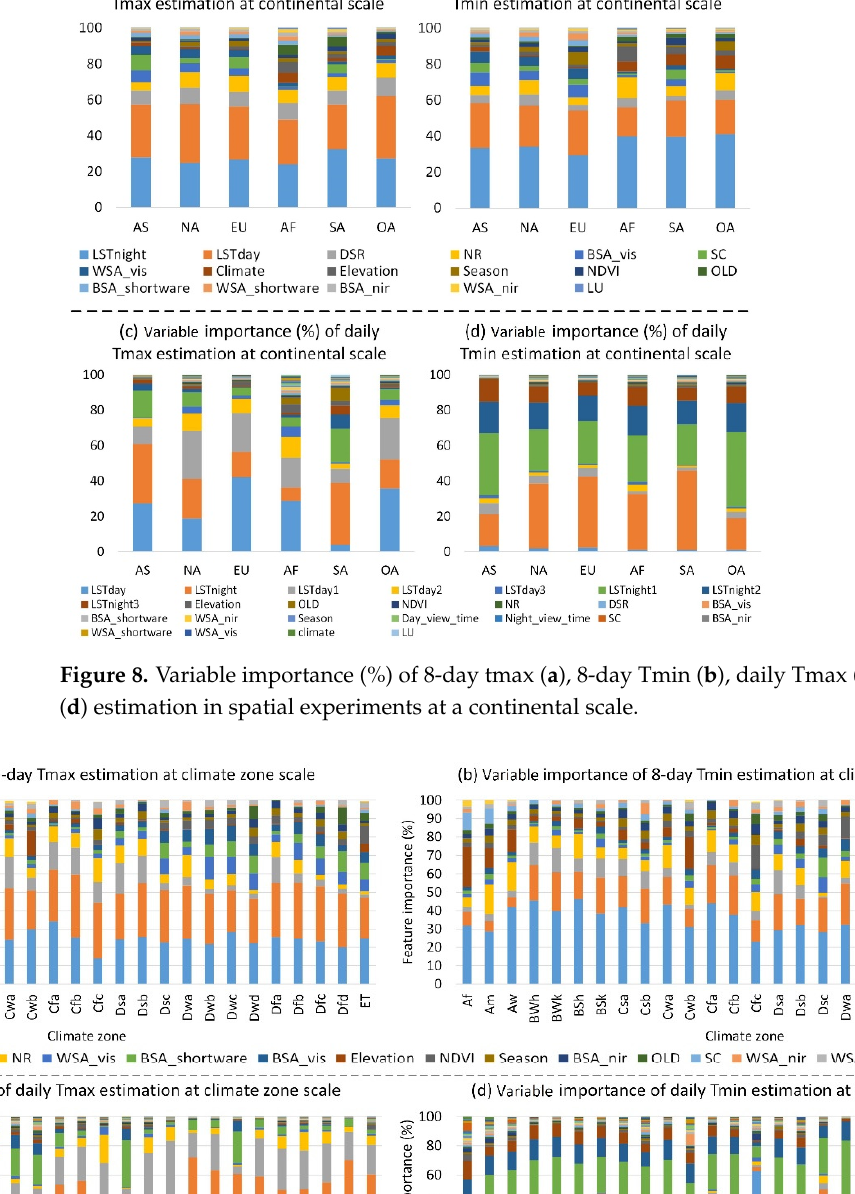
Figure 7. Variable importance (%) of 8-day ( a ) and daily ( b ) Tmax and Tmin in spatial experiments on a global scale.